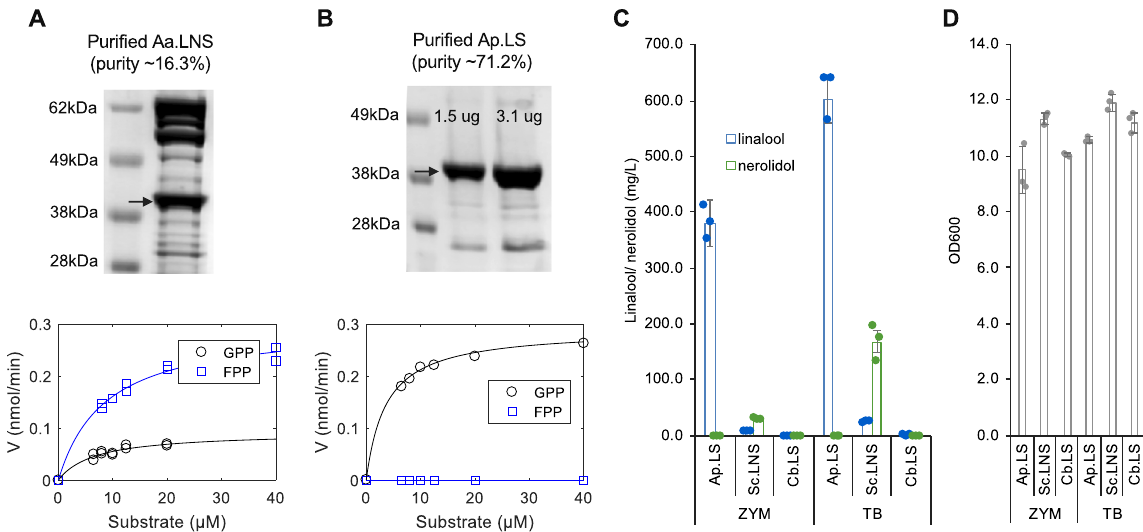
Fig. 4 In vitro characterization of Aa.LNS and Ap.LS and in vivo comparison of linalool synthases from different kingdoms in linalool bioproduction. A SDS-PAGE gel image of puri fi ed Aa.LNS and its kinetic analysis. B Protein gel of puri fi ed Ap.LS and its kinetic analysis (no product was observed for FPP). C In vivo linalool yield comparison of linalool synthases from a fungus, a bacterium, and a plant (error bars, mean ± s.d., n = 3). D The OD 600 of different strains in Fig. 3C. Ap.LS, Sc.LNS, and Cb.LS from Clarkia breweri (Q96376) were selected as the representative of kingdoms fungi, bacteria, and plantae, respectively. Table 1 Comparison of kinetic parameters for linalool synthases and LNSs from fungi, plant, and